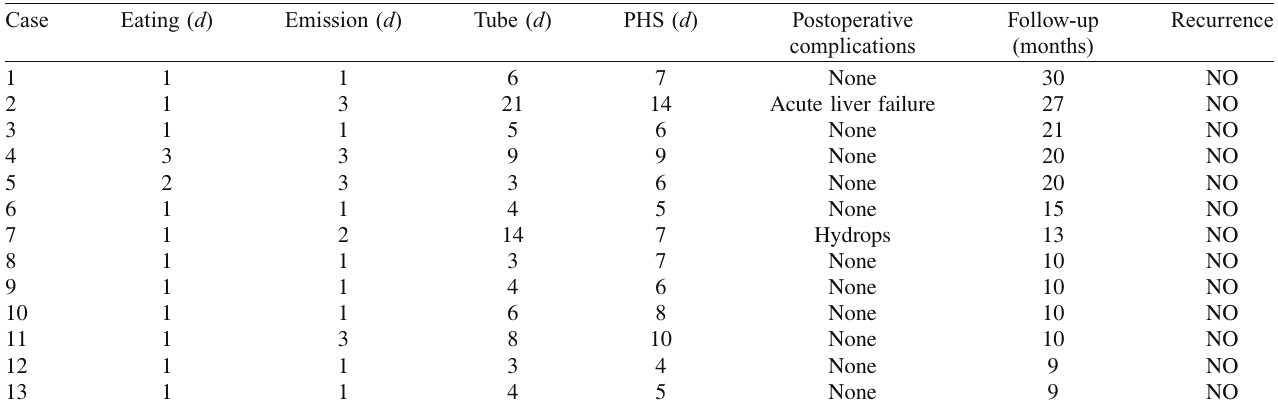
Table 3. Postoperative and follow-up information. Case Eating ( d ) Emission ( d